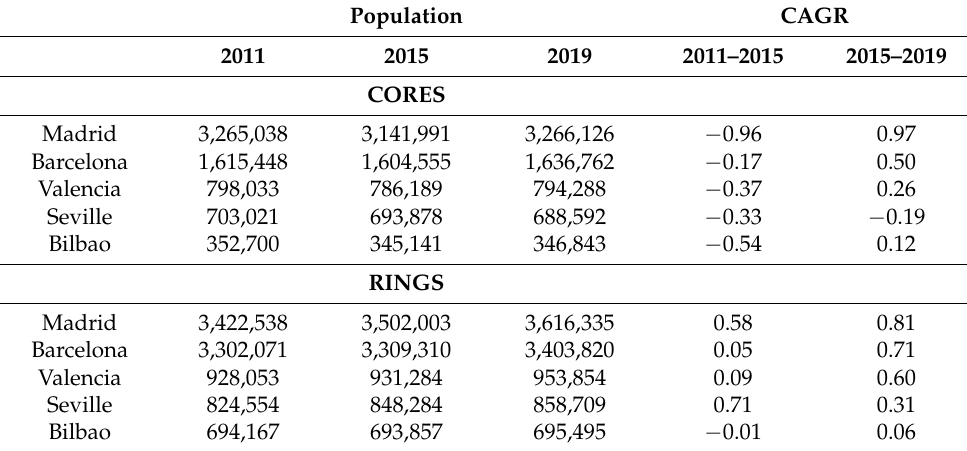
Table A2. Absolute population change and CAGRs for the 5 largest FUAs (cores and rings) in